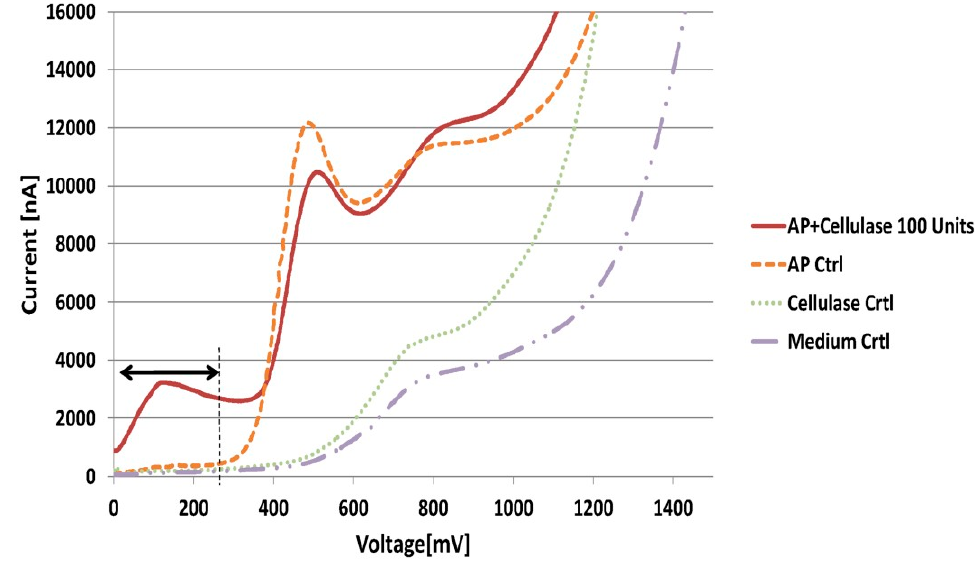
Figure 1. Evaluation of the capability of the cellulase (100 Units) to cleave the electroactive substrate APC (1 mM) after 300 min incubation (including different controls—Crtl) at a specific current rage, indicated with arrows in the